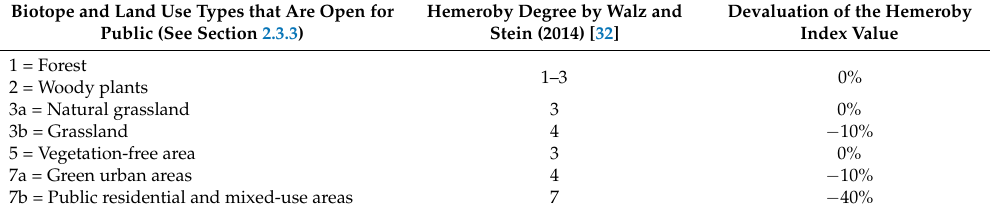
Table 7. Index values for the assessment of “rest and nature experiences.” Water (mapping unit 4) was excluded because the analysis focuses on terrestrial ecosystems. Agriculture (mapping unit 6) was regarded as not accessible for the public. The devaluation of the hemeroby index value was based on the difference to hemeroby degree 3 (most natural areas) according to Walz and Stein (2014) [32]. Biotope and Land Use Types that Are Open for Public (See Section